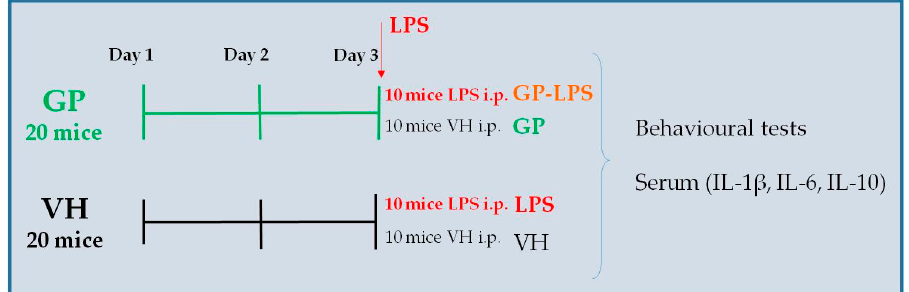
Figure 2. Experimental design applied to test the motility and anti-inflammatory effects of Gyno- stemma pentaphyllum (var. Ginpent) (GP). The groups were: control group treated with vehicle (VH, saline solution), group treated with Ginpent ® (GP). On the third day, ten GP (GP-LPS) and ten VH mice received the inflammatory stimulus, lipopolysaccharide (LPS).